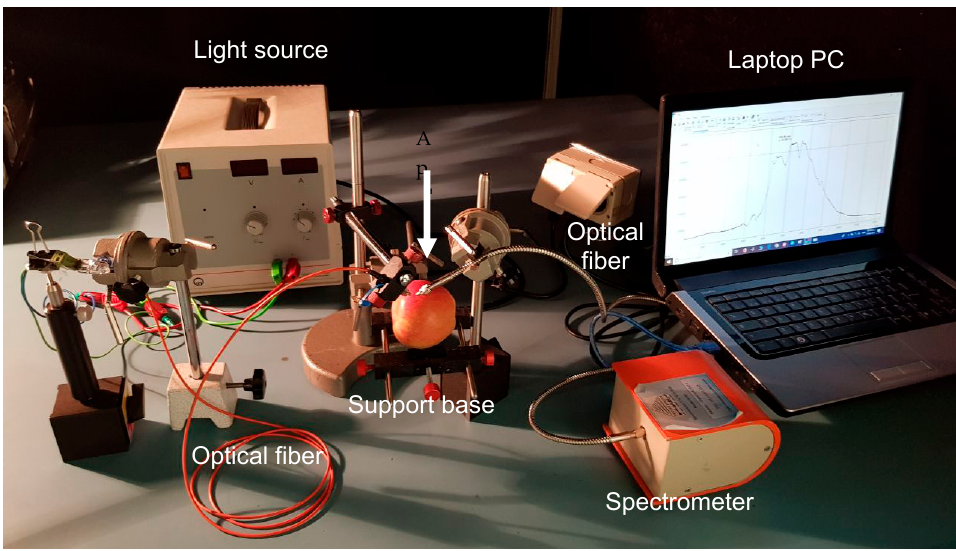
Figure 1. Configuration of the spectroscopy system used in this study.